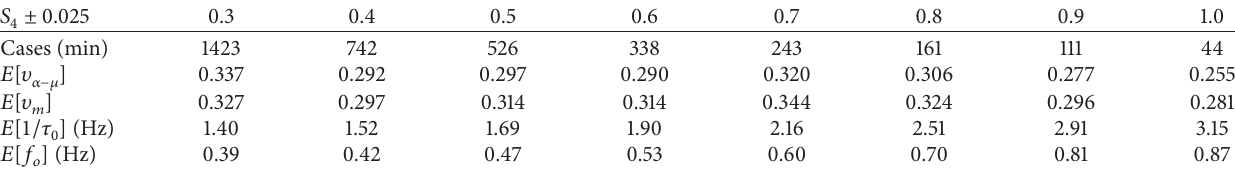
Table 1: Error results for the validation of the power spectral density